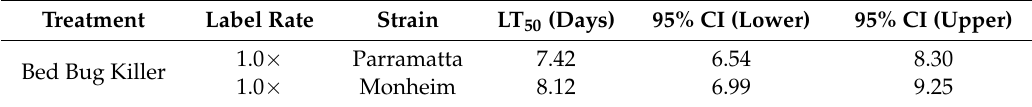
prescribed label rate, with 50% mortality expected after ≈ 7.5–8 days of continuous exposure. Table 3. LT 50 values in days (±95% confidence intervals) for Parramatta (resistant) and Monheim (susceptible) Cimex lectularius when assayed against Bed Bug Killer Powder (only tested at 1.0× label rate).